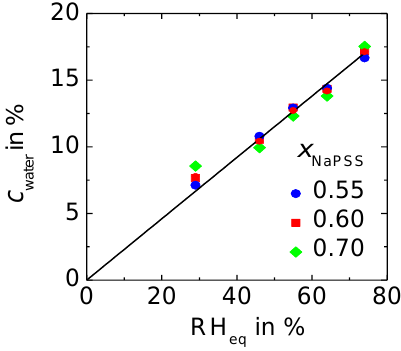
Figure 2. Influence of the relative humidity of the environment on PEC: Water content of x NaPSS∙(1 − x ) PDADMAC at ambient temperature.